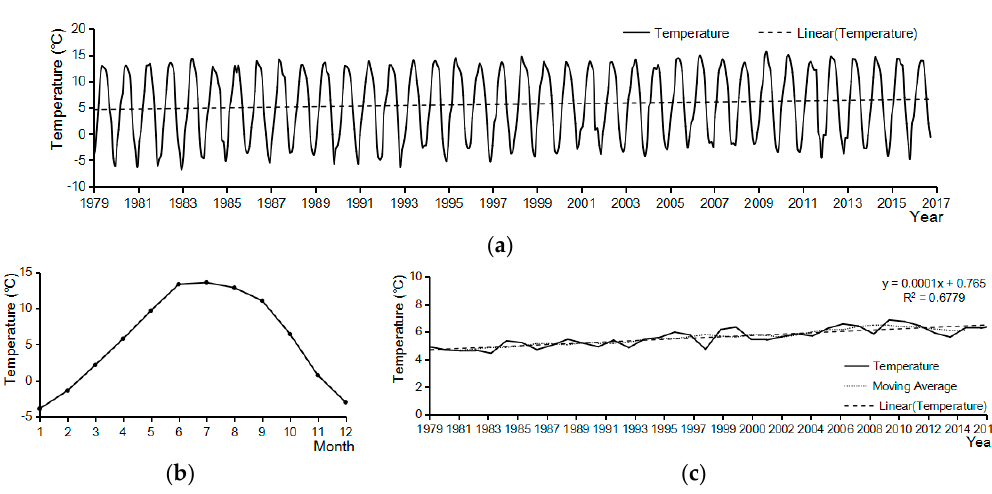
Figure 4. Characteristics of temperature changes in the midstream region of the Yarlung Zangbo River basin. ( a ) Time series of monthly temperature; ( b ) The secular mean monthly temperature; and, ( c ) The mean annual temperature.